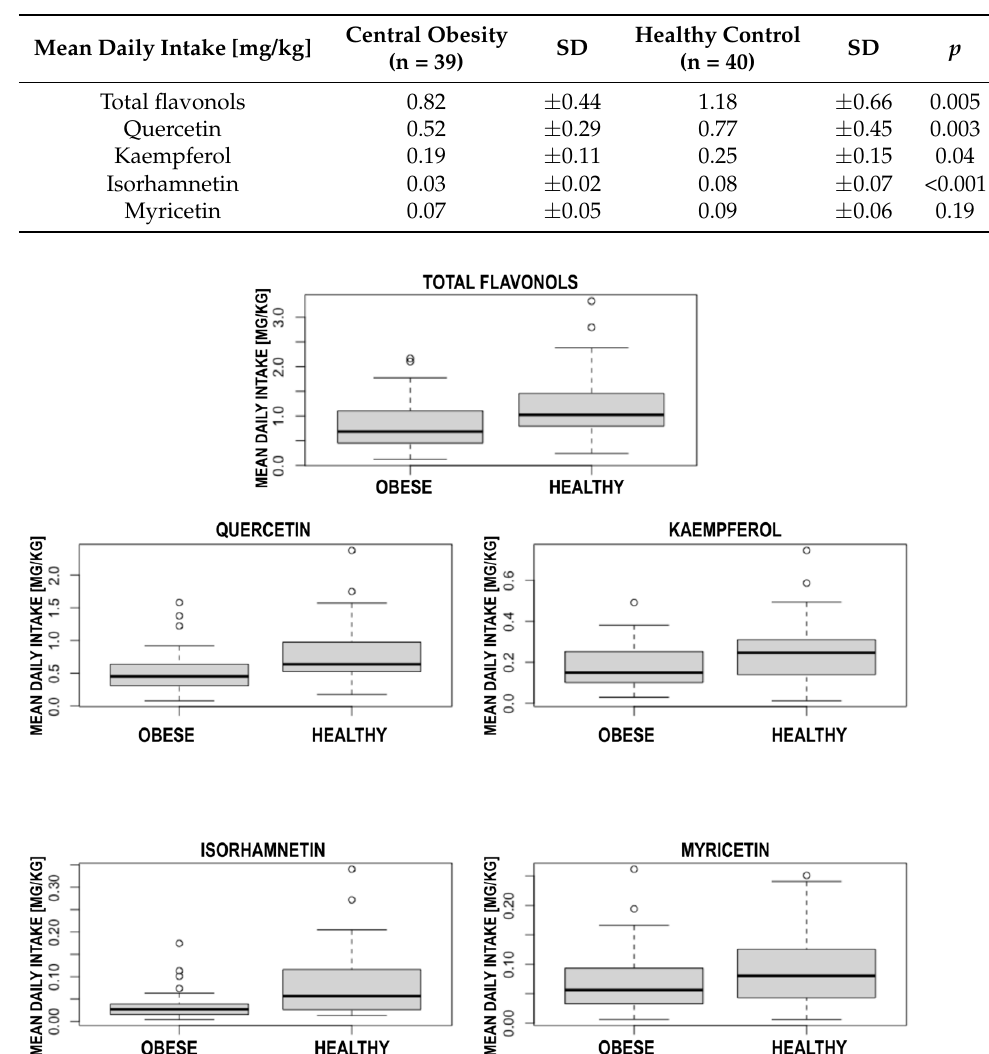
Table 3. The comparison of flavonol intake between central obesity participants and healthy control.